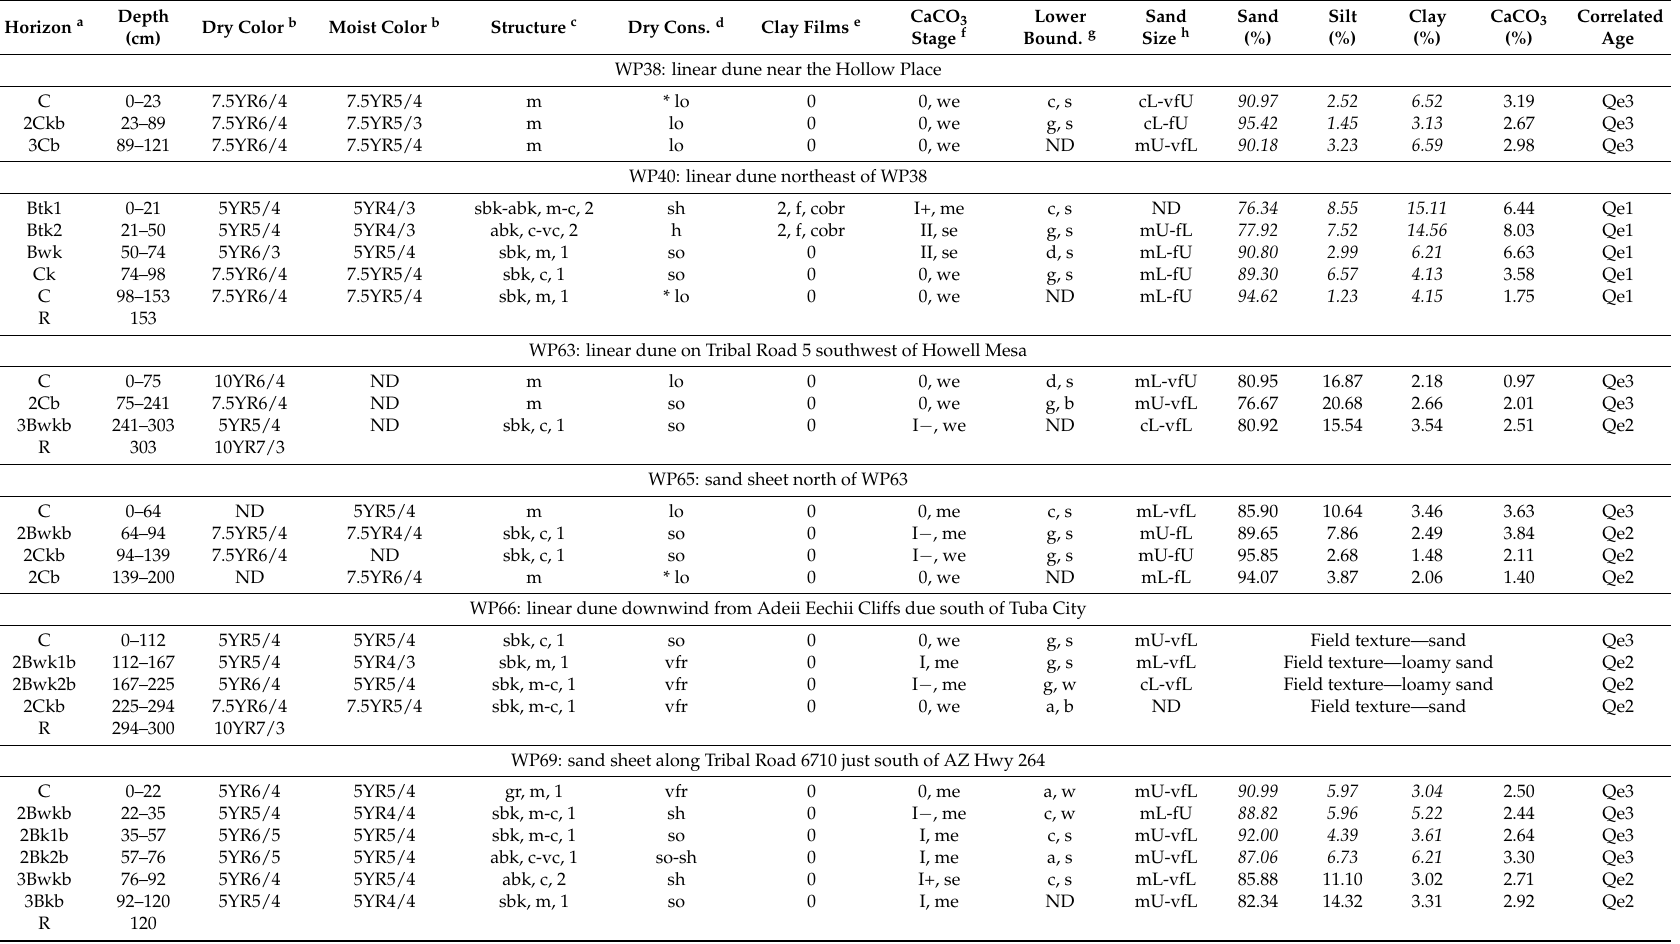
Table 4. Soil descriptions and laboratory